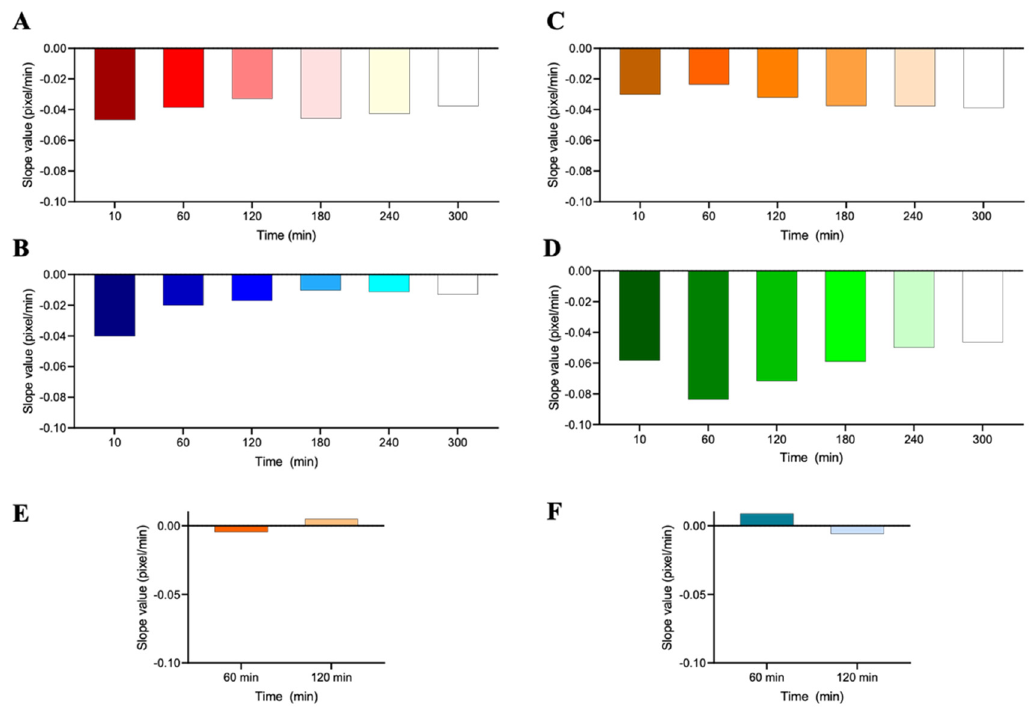
Figure 21. The slopes of the decrease in the total displacement as a function of time are calculated based on the time points 10, 60, 120, 180, 240, and 300 min during 0.5 µg/mL caspofungin or fluconazole treatment for the averages of the total displacements of all 20 cells: ( A ) Caspofungin- treated CAF2-1, ( B ) Caspofungin-treated DSY1024, ( C ) Fluconazole-treated CAF2-1, ( D ) Fluconazole- treated DSY1024 during the 2 h growth in YDP medium of ( E ) CAF2-1 and ( F )